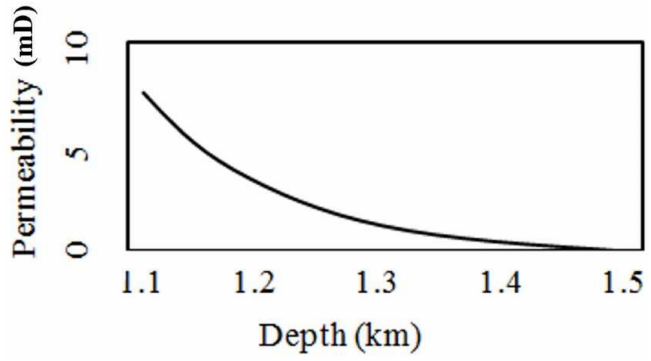
Figure 2. Variation of coal permeability with seam location [30].